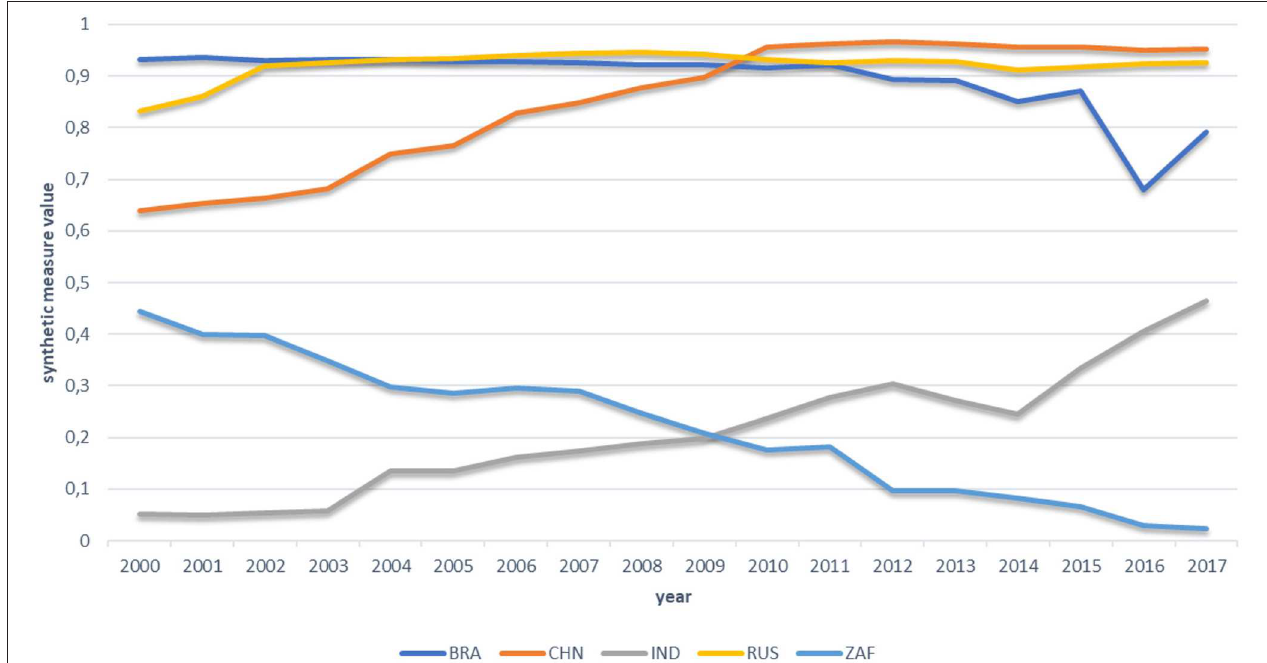
FIGURE 1 | Synthetic measure of health system performance for BRICS countries in period 2000–2017. BRA, Brasil; CHN, China; IND, India; RUS, Russia; ZAF, South Africa.